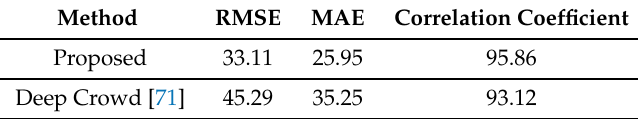
Table 5. The performances of the competing methods on the kernel counting task of 20 different corn